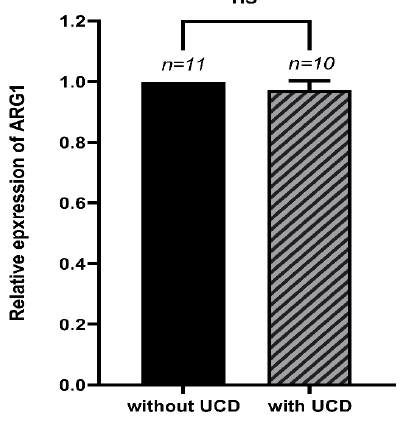
Figure 2. The relative expression of Arg1 in COVID-19 patients with or without the underlying chronic disease (UCD). There were no significant differences in the expression of Arg1 between the COVID-19 patients with the UCDs and the COVID-19 patients without UCDs. The numbers of COVID-19 patients with UCDs and without UCDs were 10 and 11, respectively .